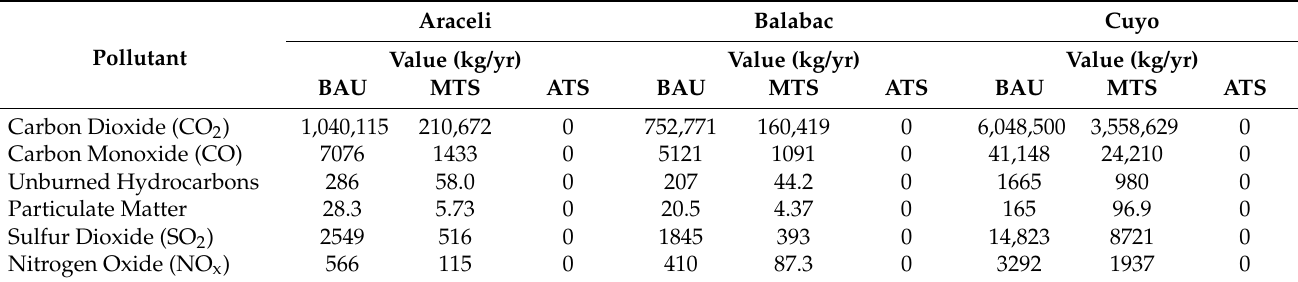
Table 6. Pollutant emissions of the optimal configurations for MTS and